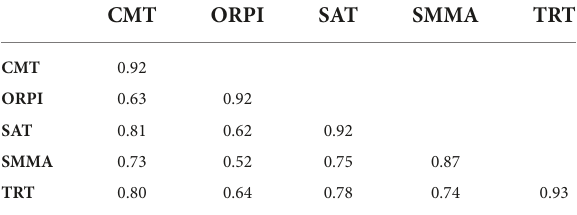
TABLE 3a Fornell-Larcker criterion.